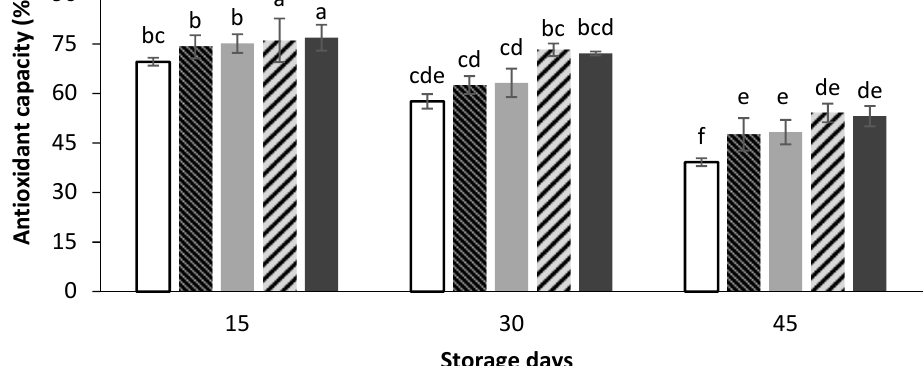
Figure 9. Effects of chitosan, phenylalanine, and chitosan-coated phenylalanine nanoparticles treatments on the antioxidant capacity of persimmon fruit during storage at 4 °C for 15, 30, and 45 days. Each value represents the mean ± standard errors of three replications. Different letters indicate statistical differences using Duncan’s multiple range tests at P < 0.05 level.